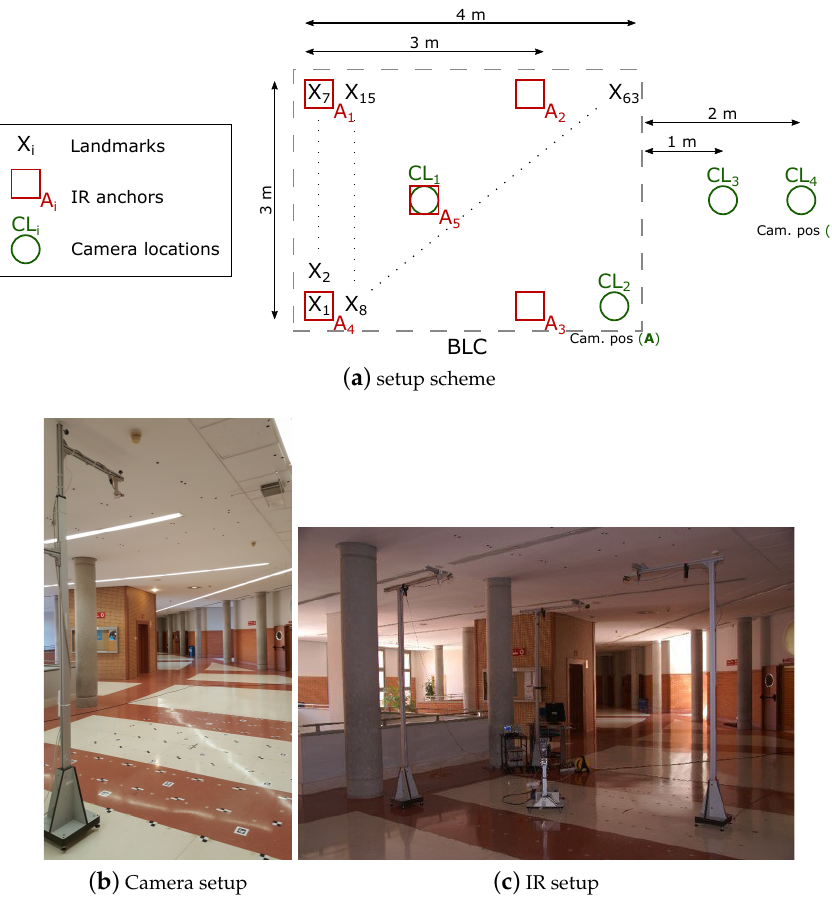
Figure 7. Setup for